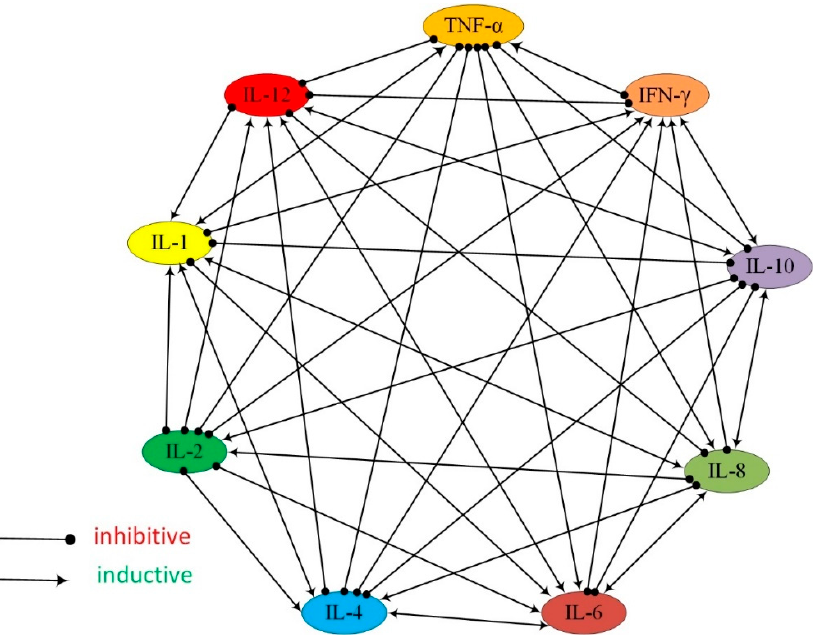
Figure 1. The interaction network of the 9 cytokines studied in this work. The arrow ending indicates the inductive effect, while the solid circle ending means inhibitive effect. For example, the link from IFN- γ to IL-6 ends with a solid circle. This indicates the inhibitive effect from IFN- γ to